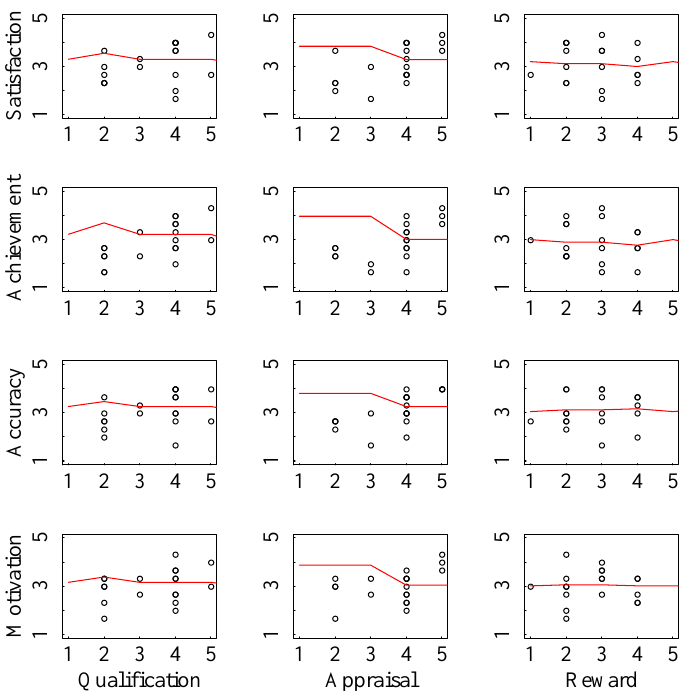
Figure 3. Correlation analysis of performance measures ( Y 1 , . . . , Y 4 ) on selected key training method variables ( X 7 , X 8 , X 9 ) for employees in the banking